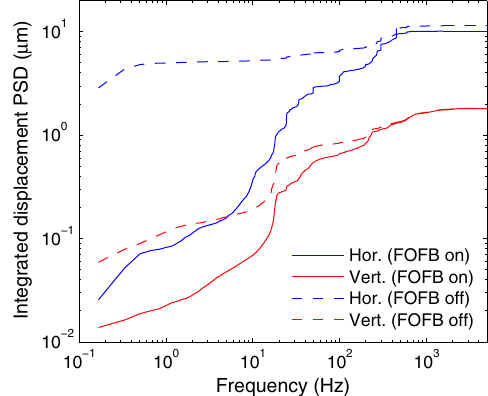
FIG. 14. Integrated beam motion with and without orbit feed- back for (cid:3) 1 ¼ (cid:1) 1 (cid:5) 10 (cid:1) 5 and a cavity voltage of 1.6